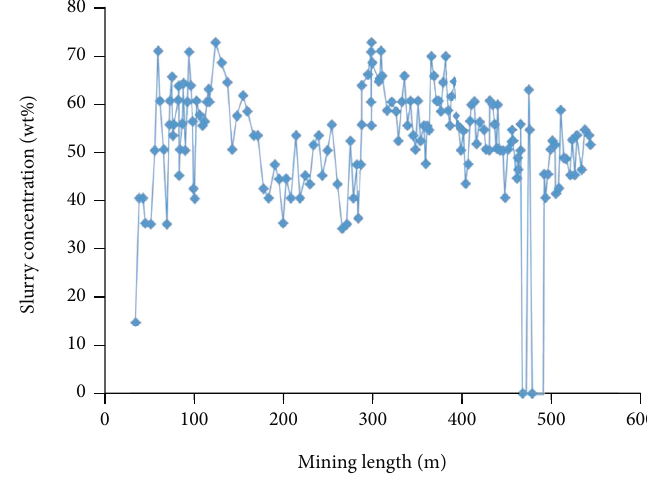
Figure 10: Concentration curve of slurry.